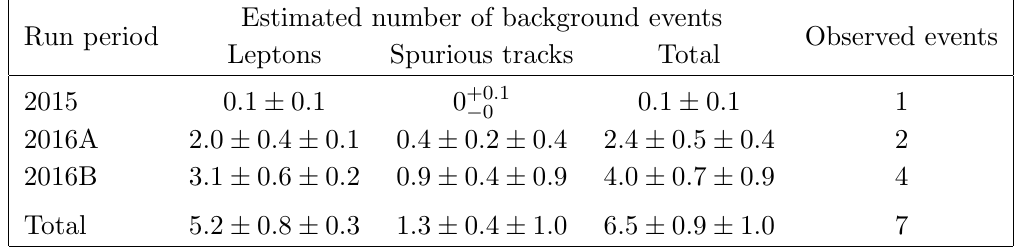
Table 4 . Summary of numbers of events for the estimated backgrounds and the observed